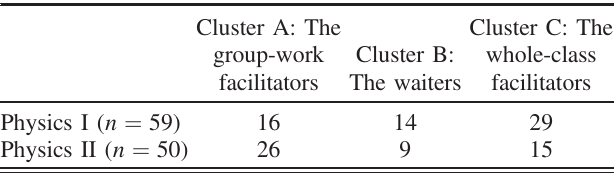
TABLE XI. Participation rates for GTAs in different courses in each